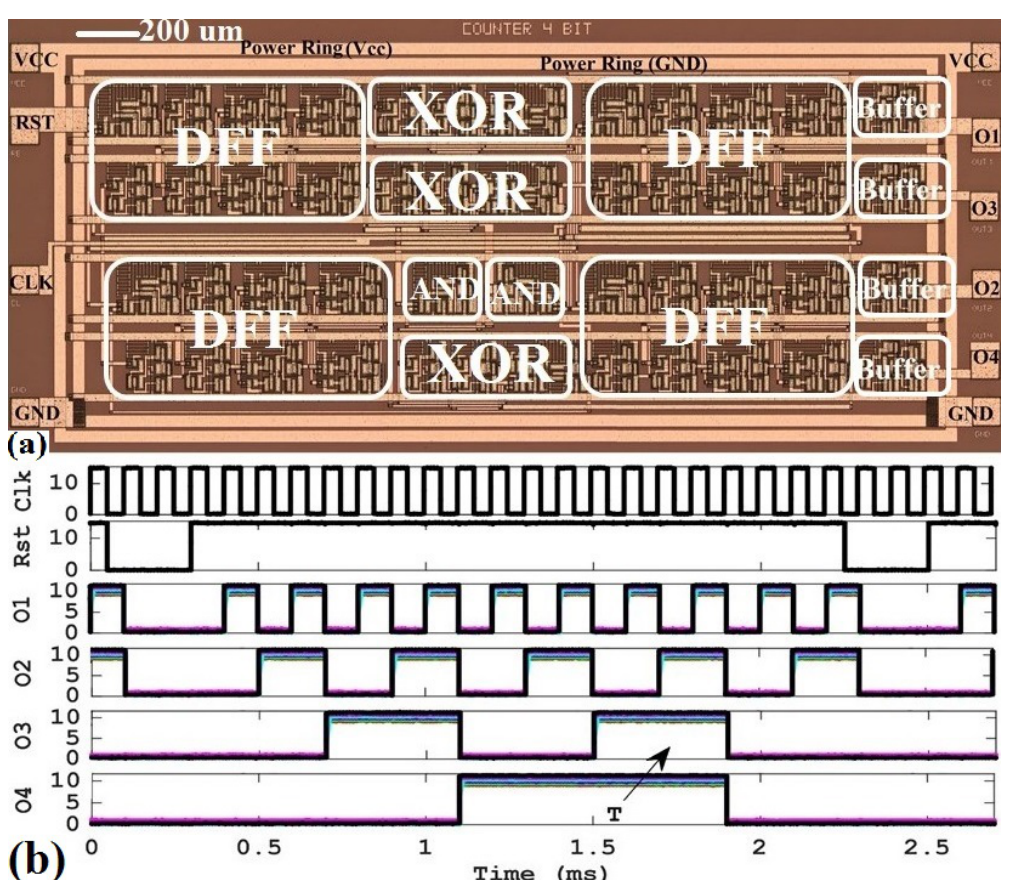
Figure 21. SiC TTL-based 4-bit counter with synchronous active low reset ( a ) micro-photograph ( b ) measured transient response in the range of T = 25–500 ○ C. The 4-bit counter counts from 0 to 15 at a positive edge of the clock, f clk = 10 kHz with V IH = 15 V and V IL = 0 V. 4 buffer/repeater circuits are used to address the low fan-out at